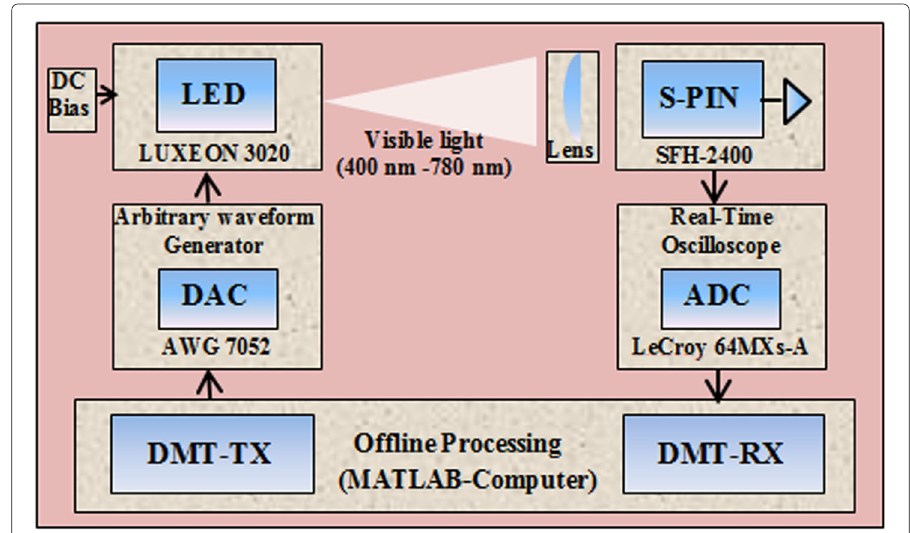
Fig. 4 Experimental setup of an indoor IM/DD VLC transmission